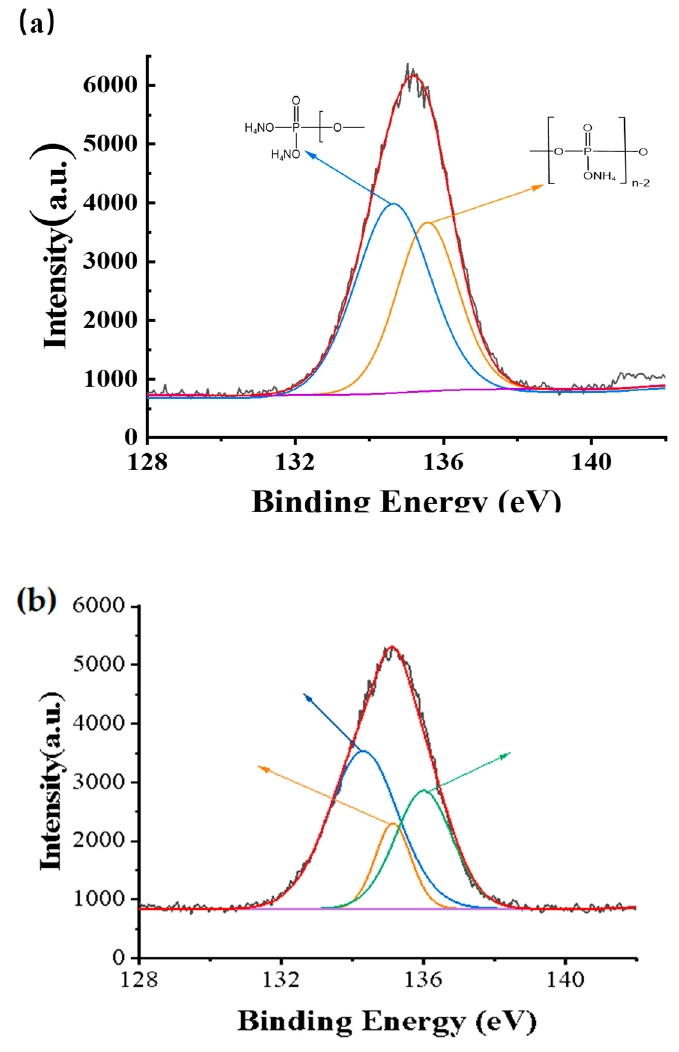
Figure 8. P 2p binding energy of APP ( a ) and KAPP ( b ).